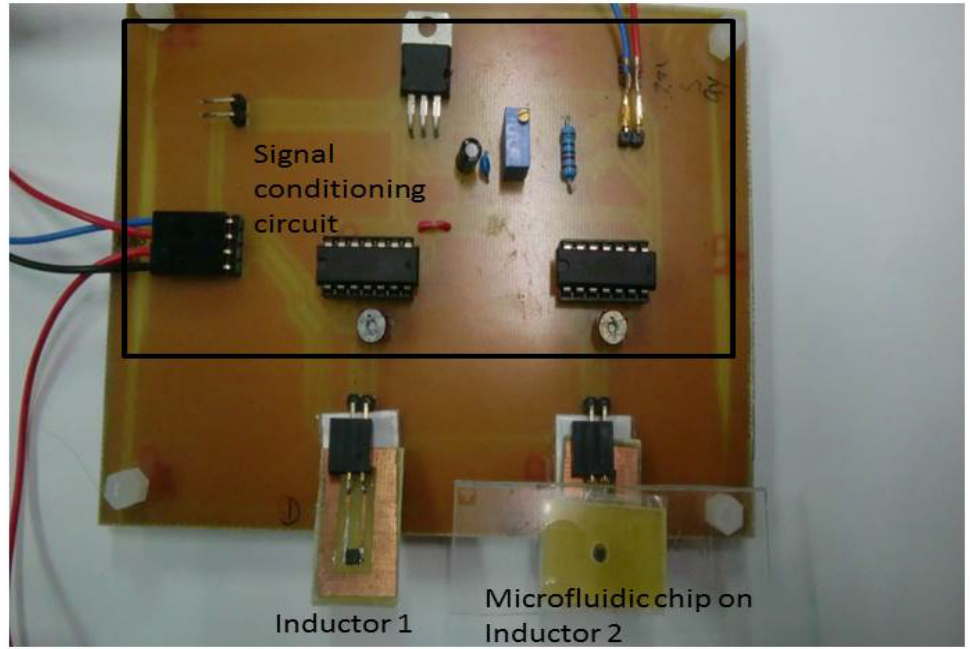
Figure 12. Differential pair of inductors measuring signal from magnetic beads on microfluidic platform.